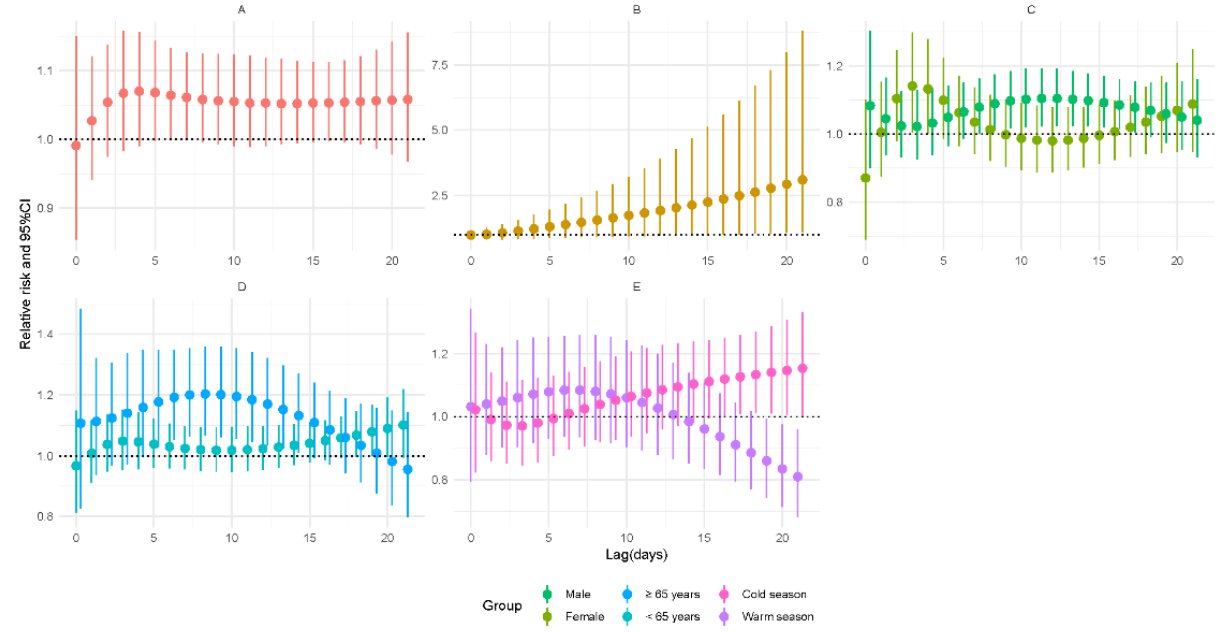
Figure 4. Relative risks for tuberculosis incidence in relation to a 50 μg /m 3 increase of daily average concentrations of particulate matter with an aerodynamic diameter less than 2.5 μm (PM 2.5 ). ( A ) Lag-specific RRs; ( B ) cumulative RRs; ( C ) stratified analysis by gender; ( D ) stratified analysis by age; ( E ) stratified analysis by season.